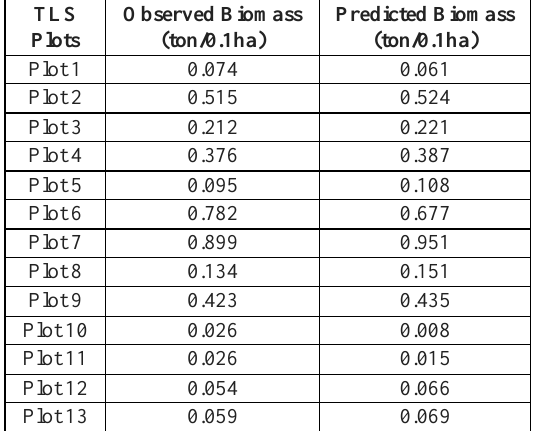
Figure 6: Shows (A) Correlation between field estimated volume and TLS modelled volume, (B) Correlation between field biomass and TLS estimated biomass, (C) Correlation between observed biomass and predicted biomass using TLS modelled volumetric equation. Using the TLS modelled volume equation, prediction of biomass was done and R 2 obtained was 0.98 between the observed and predicted biomass. The correlation plot is shown in Figure 6. The values obtained using TLS modelled equation is depicted as predicted biomass in the Table 1. The biomass was calculated for every single tree in the plot. The biomass values mentioned in the Table 1 is at plot level.